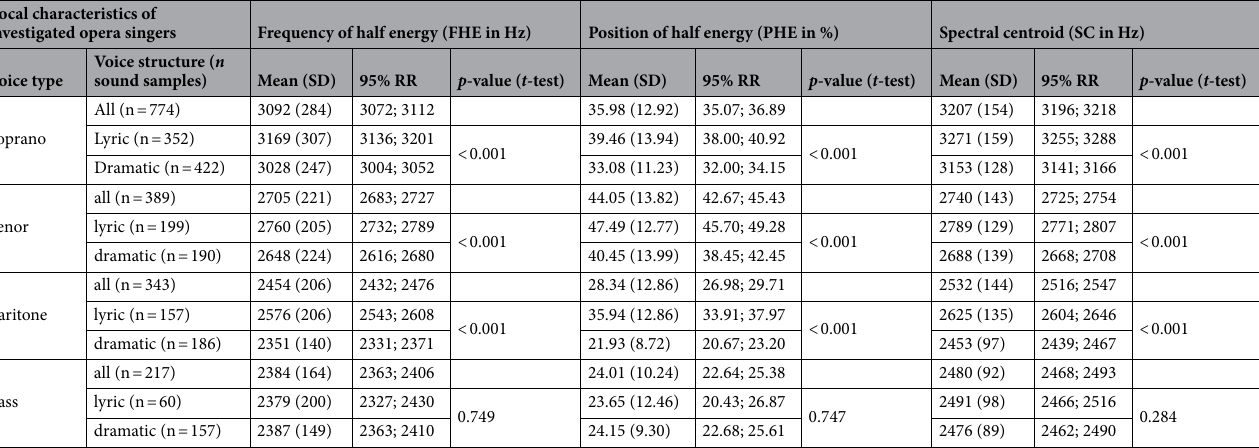
Table 1. Timbre parameters frequency of half energy (FHE), position of half energy (PHE) and spectral centroid (SC) depending on voice structure (lyric vs. dramatic) in all voice types. n number, RR reference ranges (lower bound; upper bound), SD standard deviation.